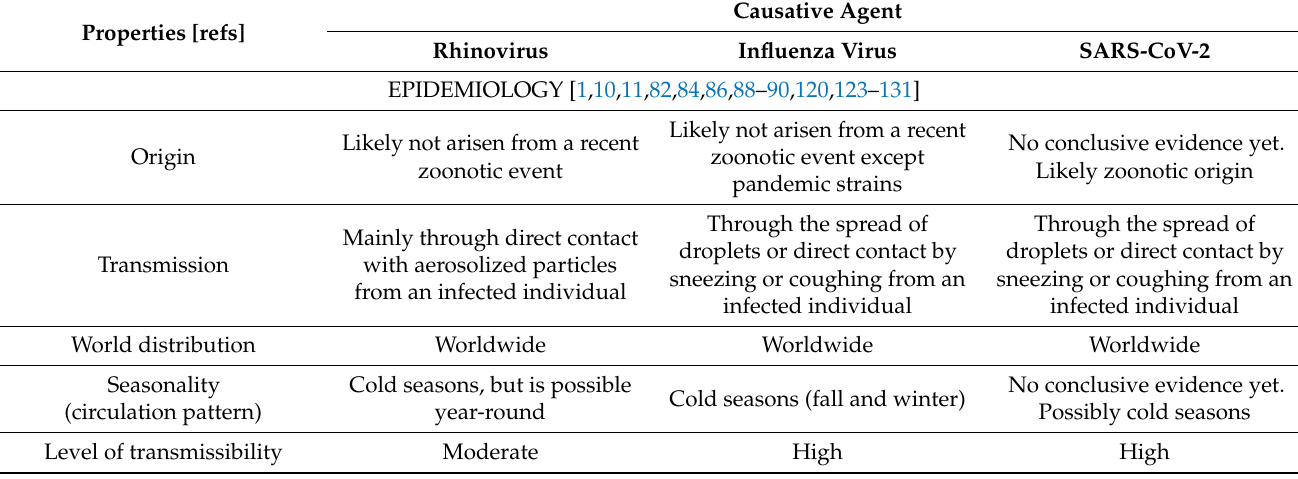
Table 3. Comparative characteristics of the common cold, influenza, and COVID-19: epidemiology. Properties